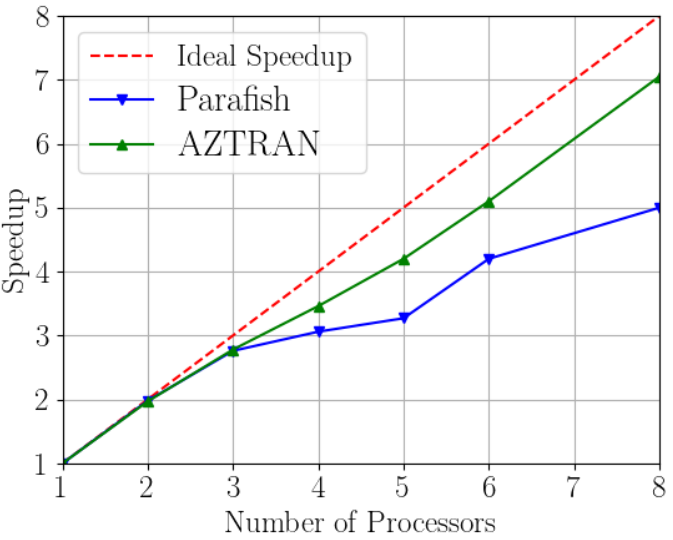
Figure 21. Speedup achieved by Parafish and AZTRAN for the small FBR